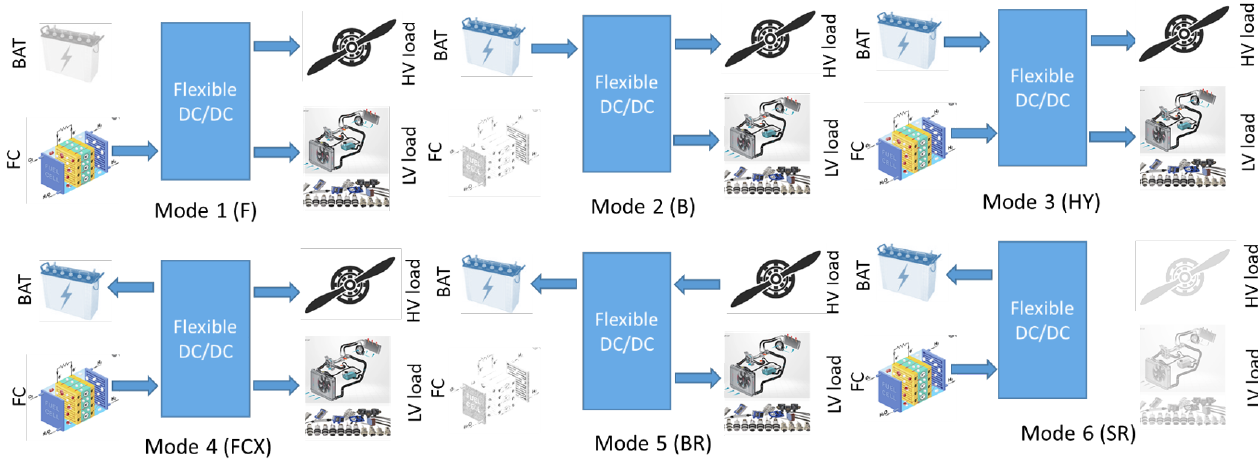
Figure 3. Different operating modes of the proposed multi-port converter in hybrid aircraft